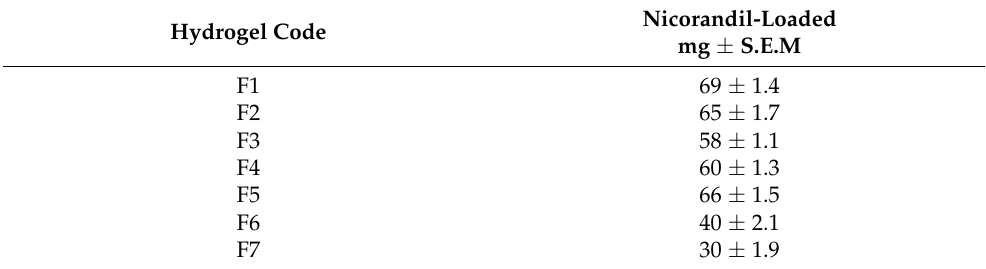
Table 2. Loaded drug in different formulations of linseed-co-AAM. Hydrogel